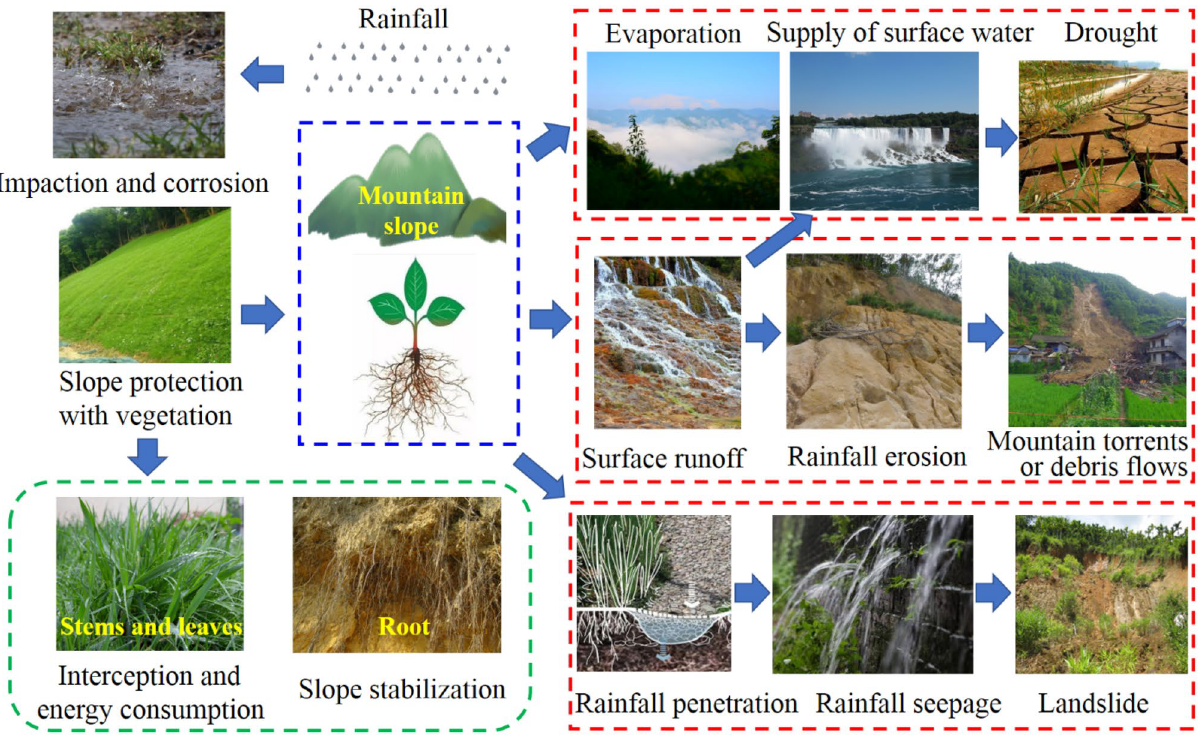
Figure 9. Rainwater shape on the vegetation-covered slopes due to rainfall and its